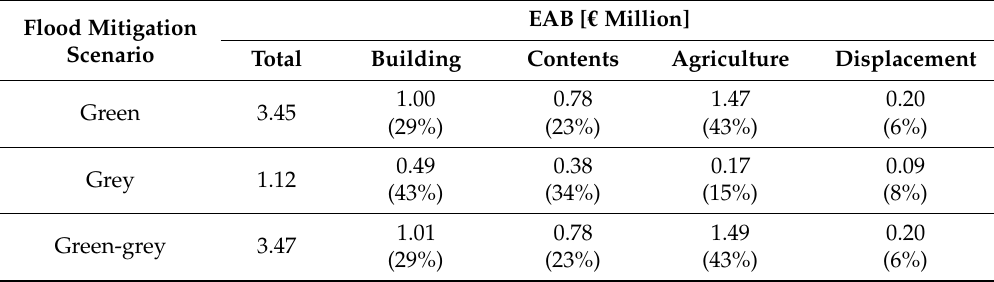
Table 7. Expected annual benefits (EABs) under three flood mitigation development scenarios and their breakdown per loss category.